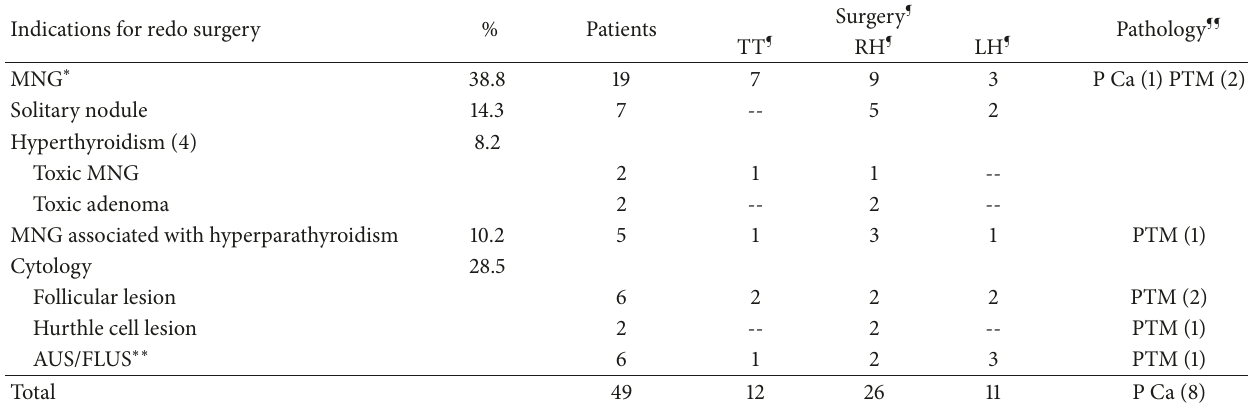
Table 1: Preoperative diagnosis and indications for thyroid surgery in patients with recurrent goiter, surgical procedures, and final malignant